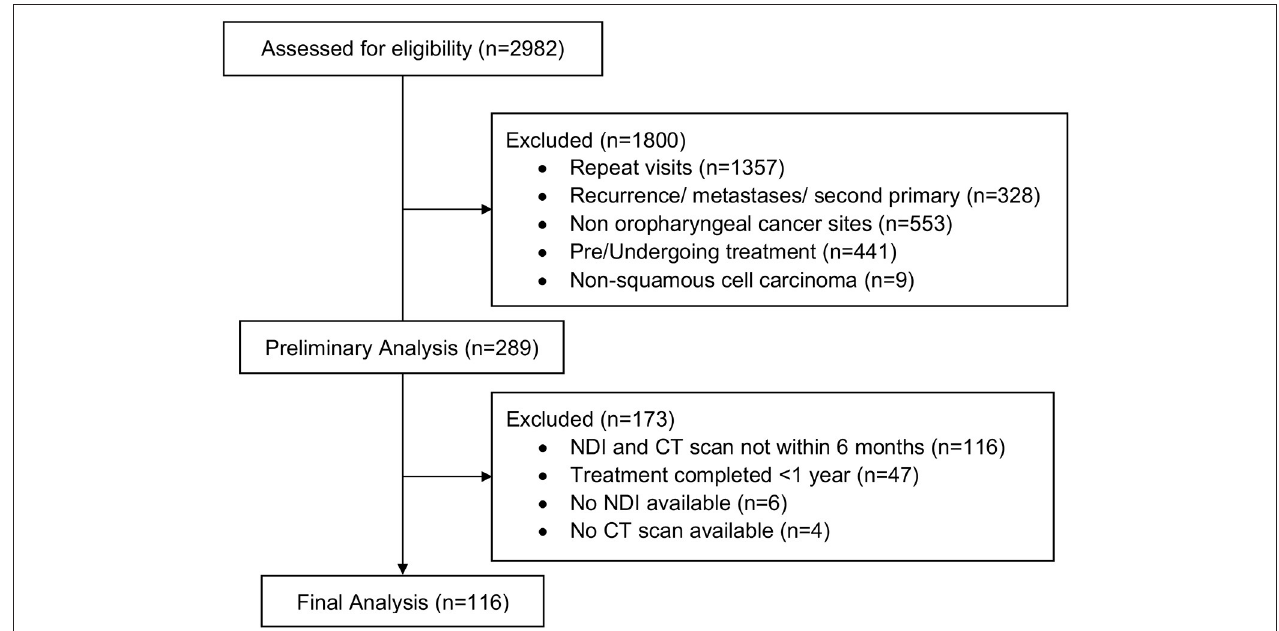
FIGURE 2 | Consort